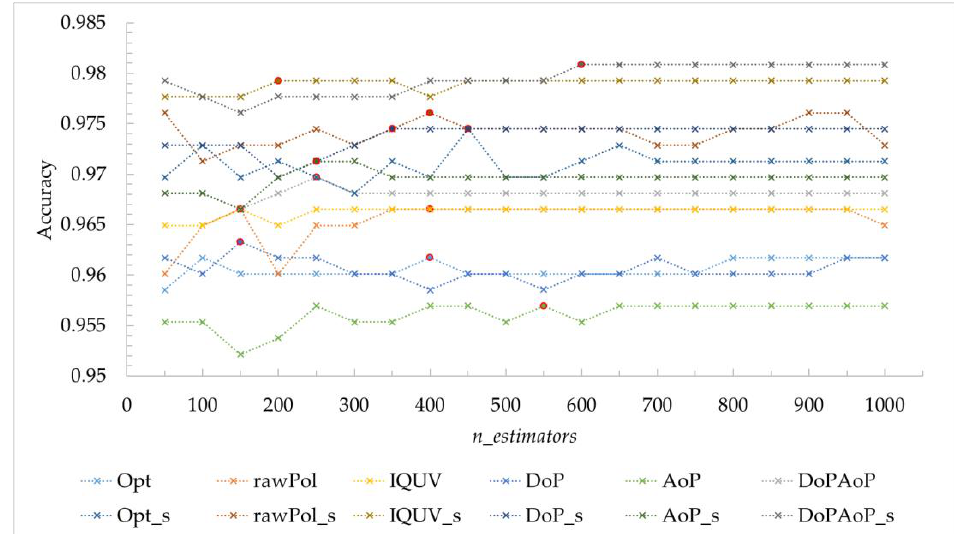
Figure 4. Determining the model parameter n_estimators by accuracy.